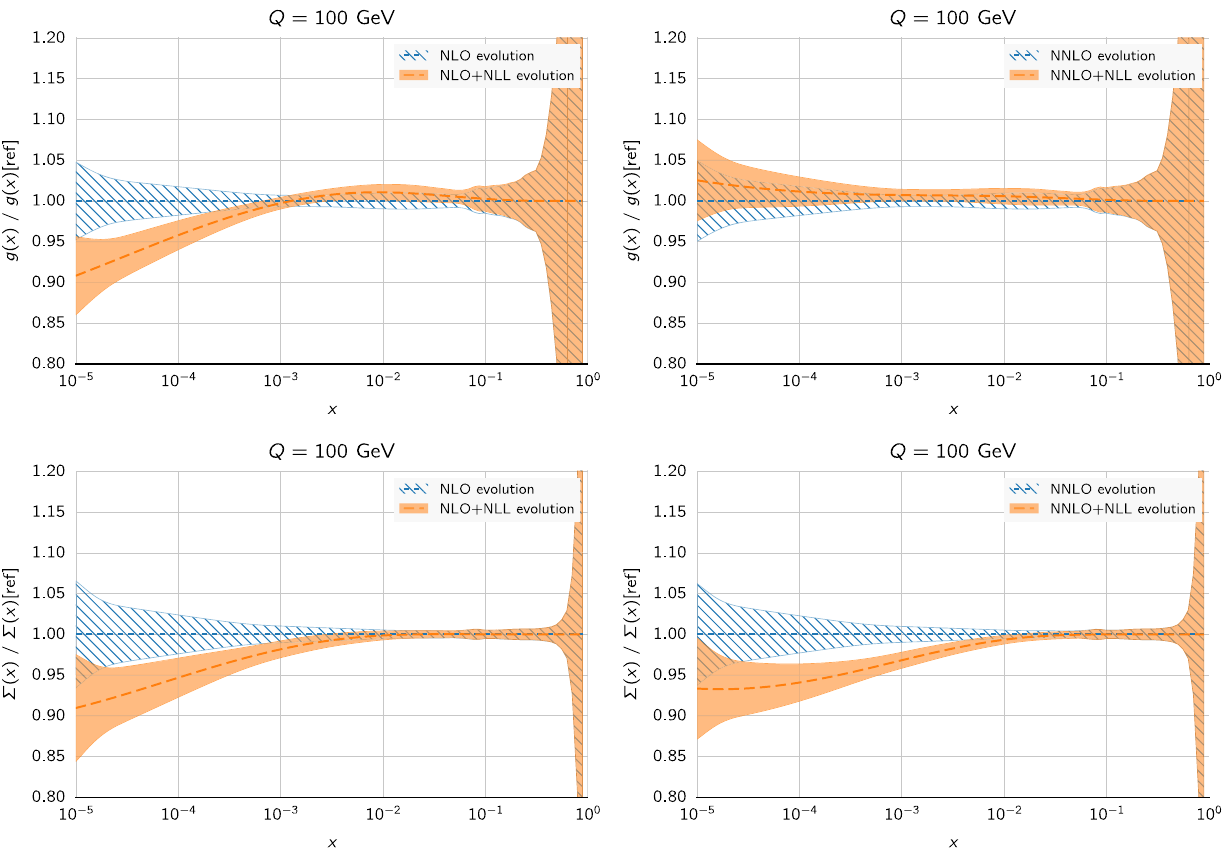
NNLO right) or resummed theory (NLO+NLL x left, NNLO+NLL x right) for the DGLAP evolution. In this specific case, the input bound- ary condition has been chosen to be NNPDF3.1 NLO